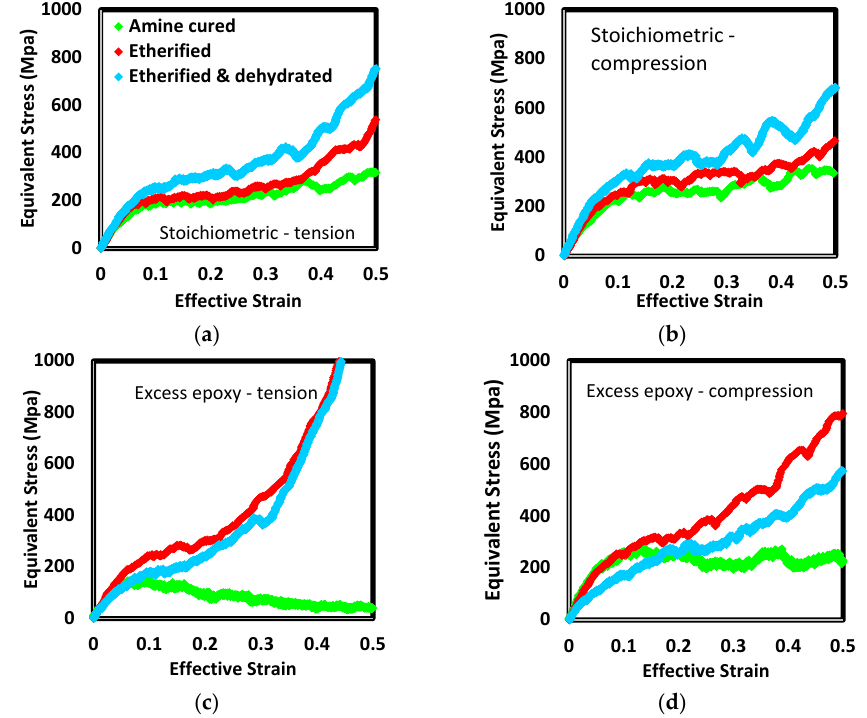
Figure 14. Equivalent stress verses effective strain for uniaxial tension ( a , c ) and compression ( b , d ) for long-chain resin at constant effective strain rate. Stoichiometric and excess-epoxide formulations are presented in ( a , b ) and ( c , d ), respectively.